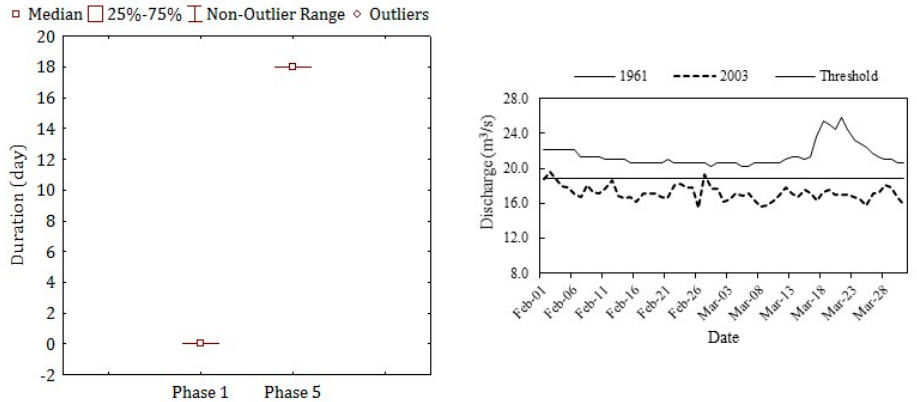
Figure 16. Comparison of duration of Phase 1 and Phase 5 (duration for other selected pairs can be found in Figure A1—A4).